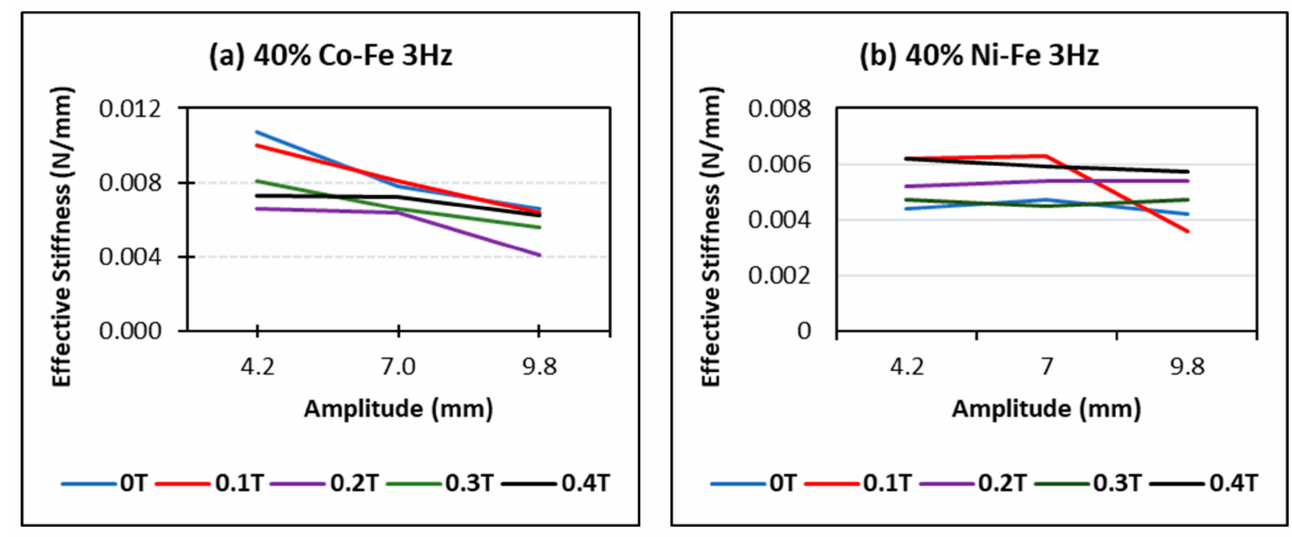
Figure 7. Effect of changing amplitude and flux at maximum filler and maximum frequency on the stiffness of ( a ) Co-Fe MRE ( b ) Ni-Fe MRE.